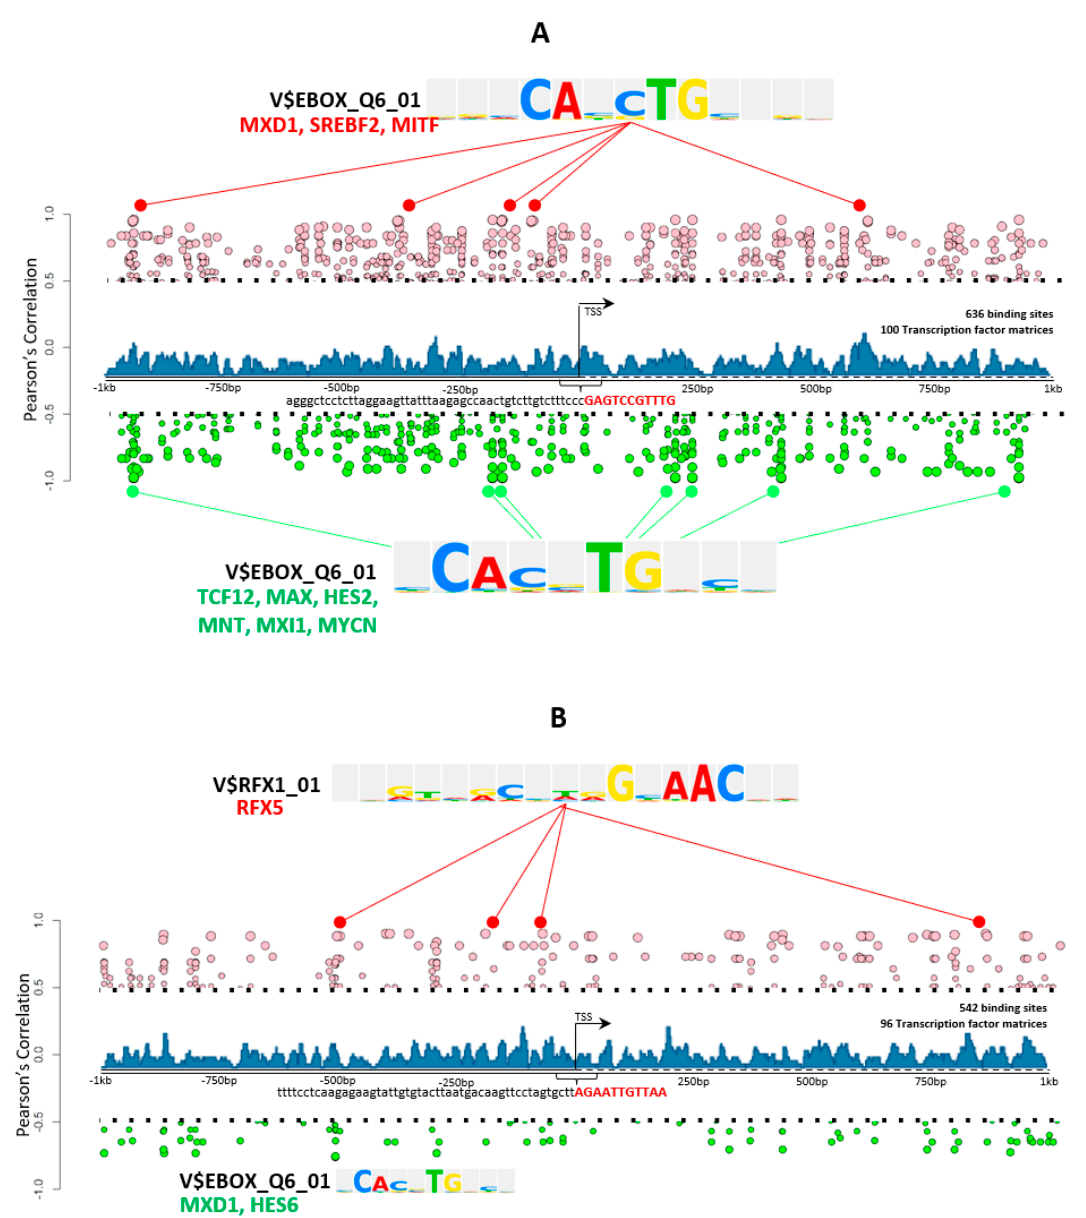
Figure 3. The transcription factor analysis of F13A1 and F13B using TRANSFAC. ( A ) An illustration of the predicted transcription factor binding to the F13A1 promoter; pink: the positively correlated expression of transcription factor with F13A1 expression; green: the negatively correlated expression of transcription factor with F13A1 expression. Blue: the density of the transcription factor at a particular position on the gene-promoter. A heatmap of transcription factors binding to a specific binding site represented as a transcription factor matrix. ( B ) An illustration of predicted transcription factor binding to the F13B promoter; pink: the positively correlated expression of the transcription factor with F13B expression; green: the negatively correlated expression of the transcription factor with F13B expression. Blue: the density of the transcription factor at a particular position. The above heatmap of the correlation between transcription factors and F13B expression; the below heatmap of transcription factors binding to a specific binding site represented as a transcription factor matrix.